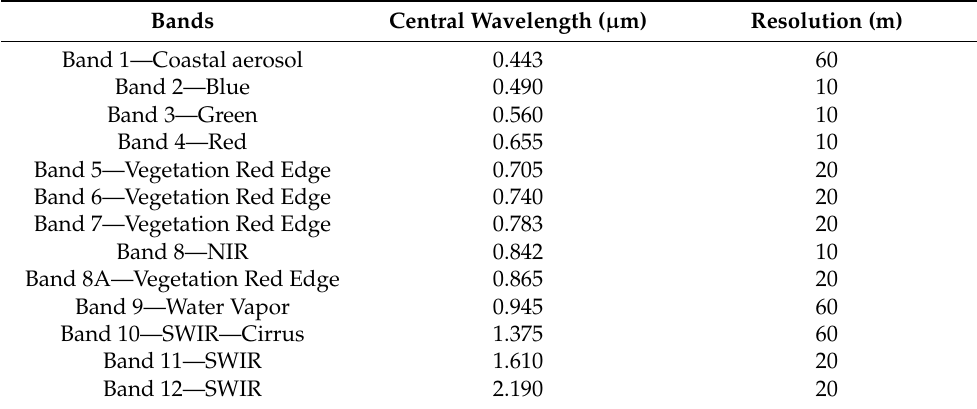
Table 1. Spectral bands and resolution of Sentinel-2 (https://sentinel.esa.int/web/sentinel/ missions/sentinel-2 accessed on 18 February